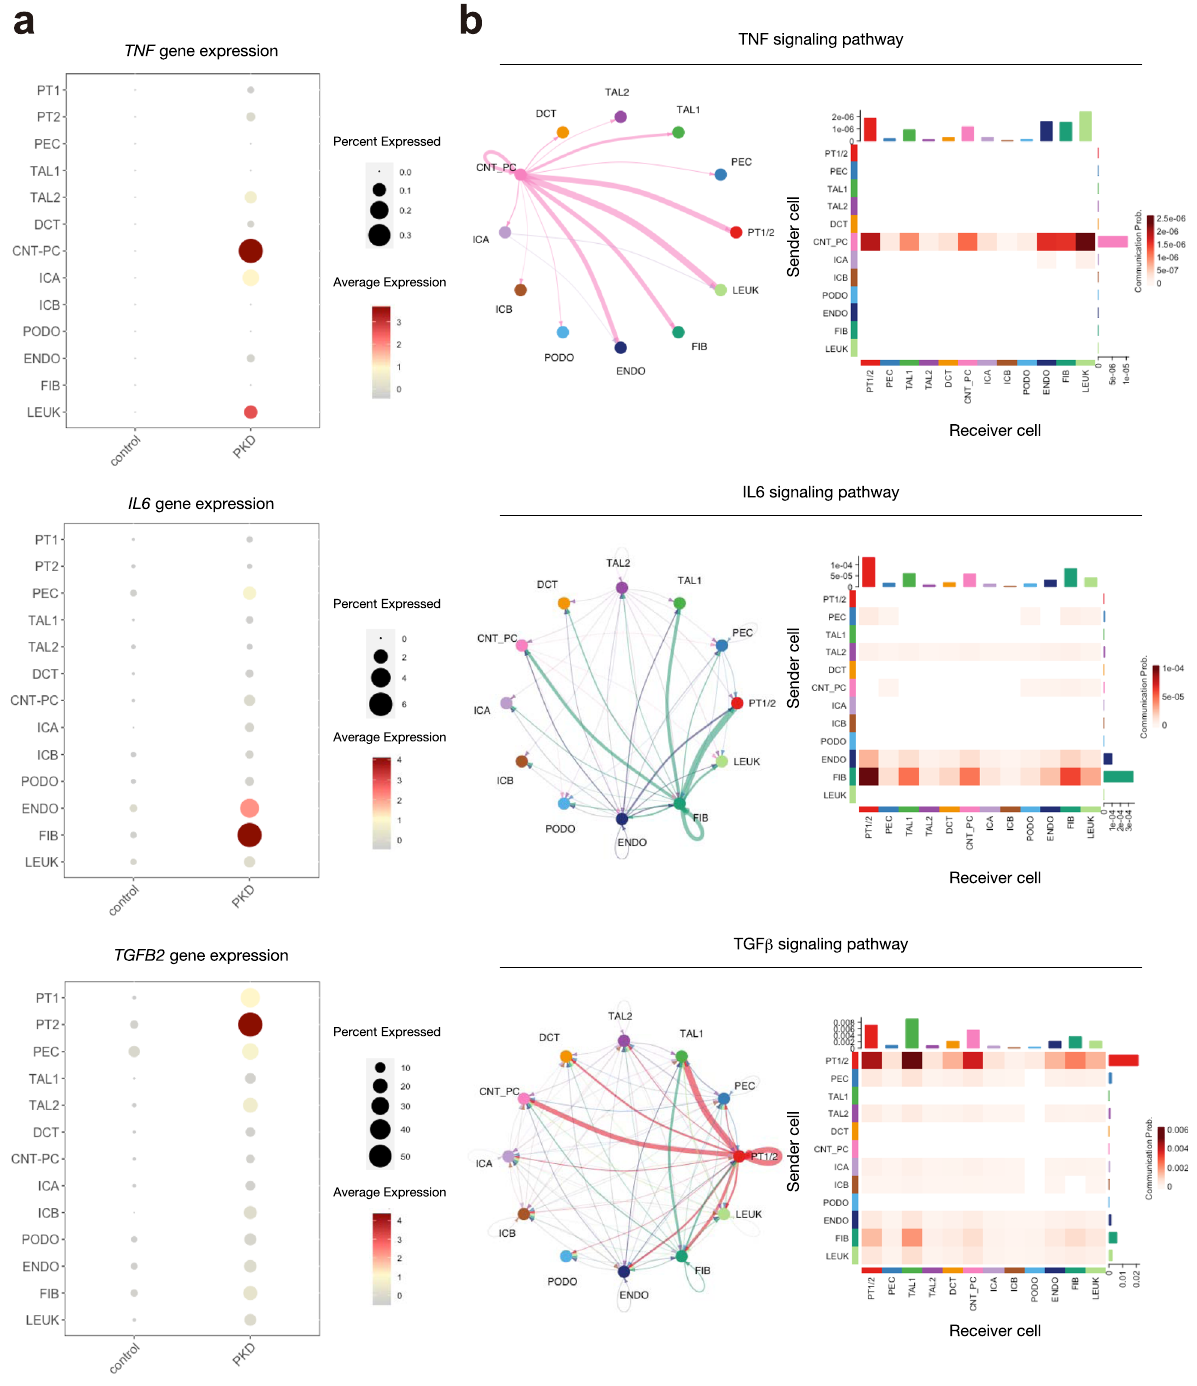
b Ligand-receptor analysis with CellChat. Circle plot showing an inferred network (left) or heatmap (right) showing communication probabilities from senders (secretors) to receivers (targets) for TNF signaling pathway (upper), IL6 signaling pathway (middle), or TGF β signaling pathway (lower). Thickness of an arrow in a circle plot indicates interaction